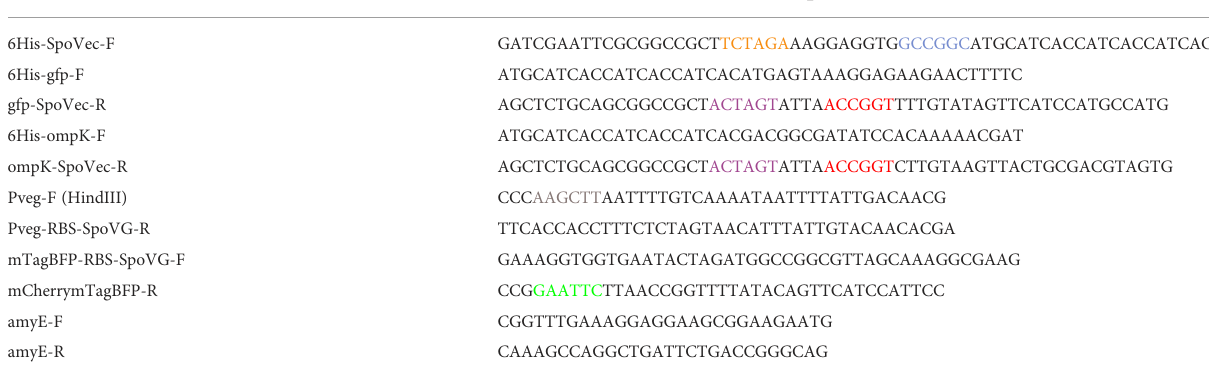
TABLE 2 List of oligonucleotide primers used in this study. Native or introduced restriction sites are indicated in different colors (NgoMIV, Xbal, AgeI, SpeI, HindIII, EcoRI). Primer